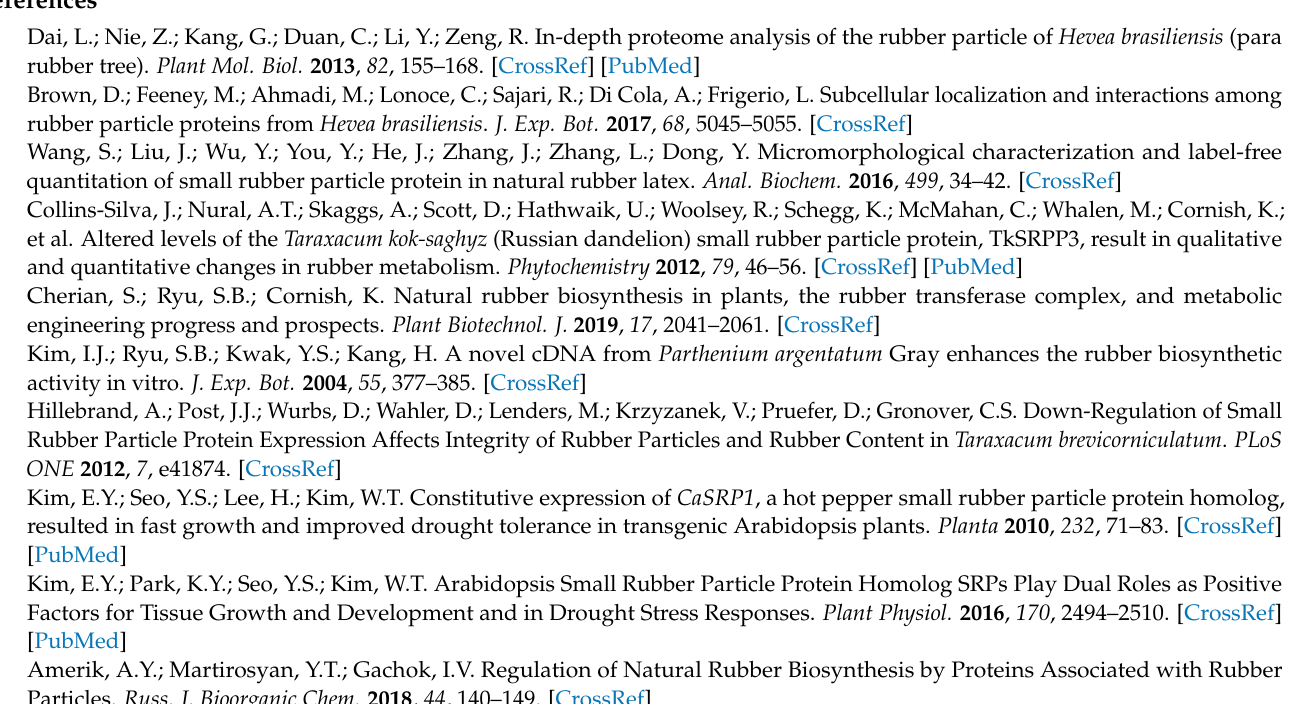
cloning; Table S2: Identification of different SRPP promoter transgenic tobacco; Table S3: Quantitative Primer sequences of TkSRPP gene; Table S4: Quantitative Primer sequences of GUS